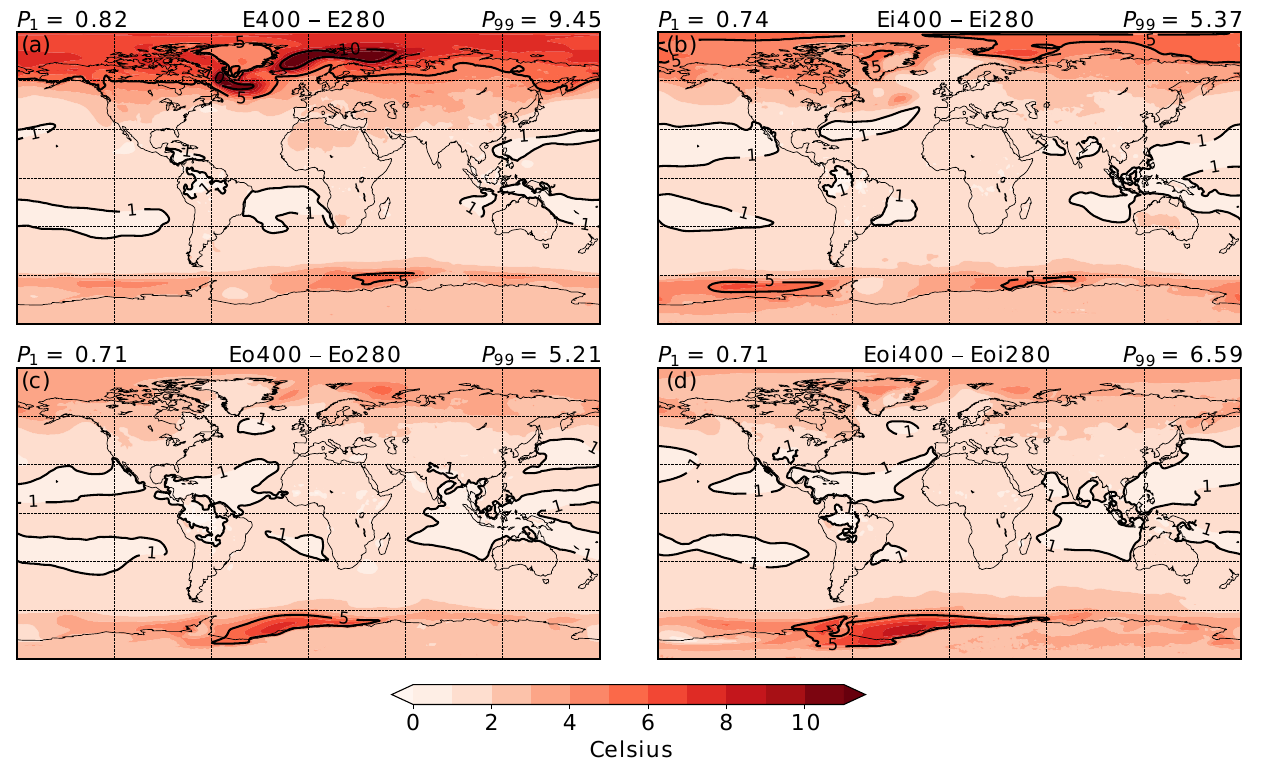
Figure 6. Climatological MASAT anomalies from a change to p CO 2 shown for all four combinations through which it can be deduced within our set of simulations. The 1st and the 99th percentiles of the anomalies are shown above each panel. The climatology years are noted in Table